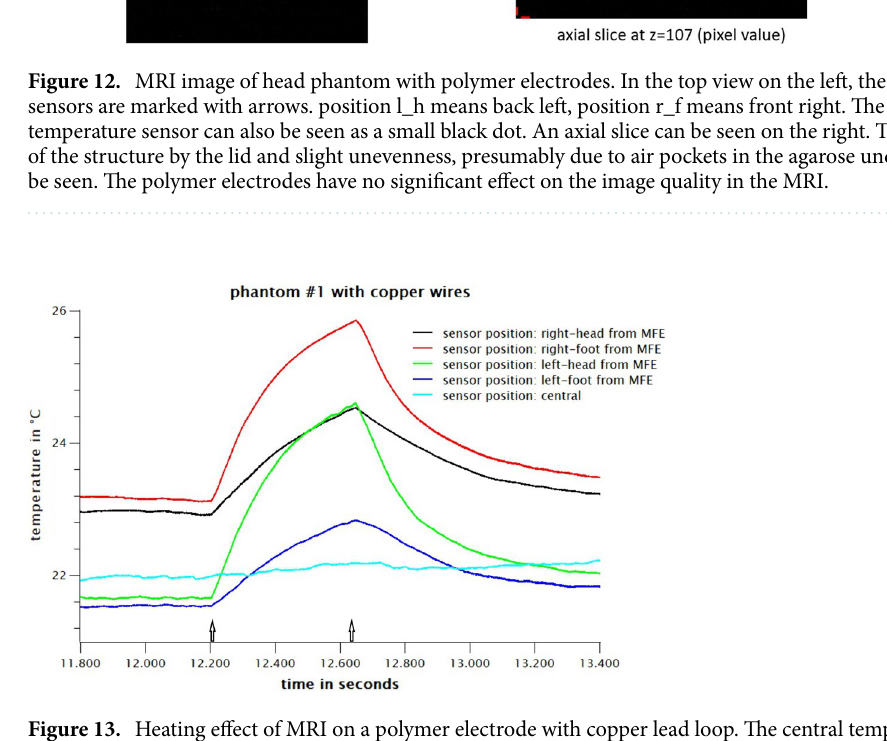
Figure 13. Heating effect of MRI on a polymer electrode with copper lead loop. The central temperature sensors serve as control. All other temperature sensors show heating effects up to 3 K. Only the temperature changes during the heating time are interesting, i.e. while the measurement sequence is running and high frequency is applied, i.e. between approx. 12220 s and 12660 s. The temperature sensors all have different offsets. For a better representation (otherwise all curves lie on top of each other) we have not corrected them. The beginning and the end of the respective measuring sequence are marked with an arrow.